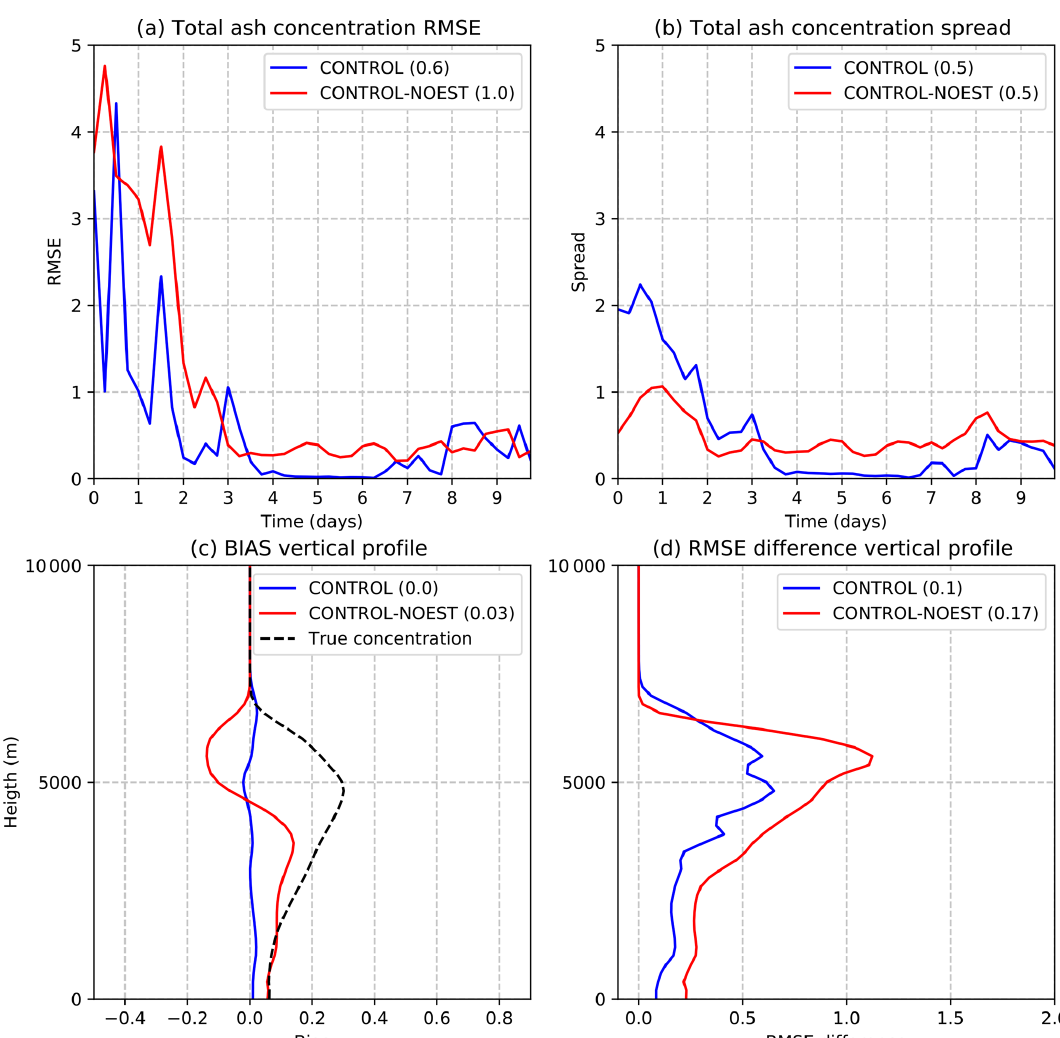
Figure 9. As in Fig. 7 but for the experiments CONTROL (blue line) and CONTROL-NOEST (red line; all values: 10 − 3 gm − 3